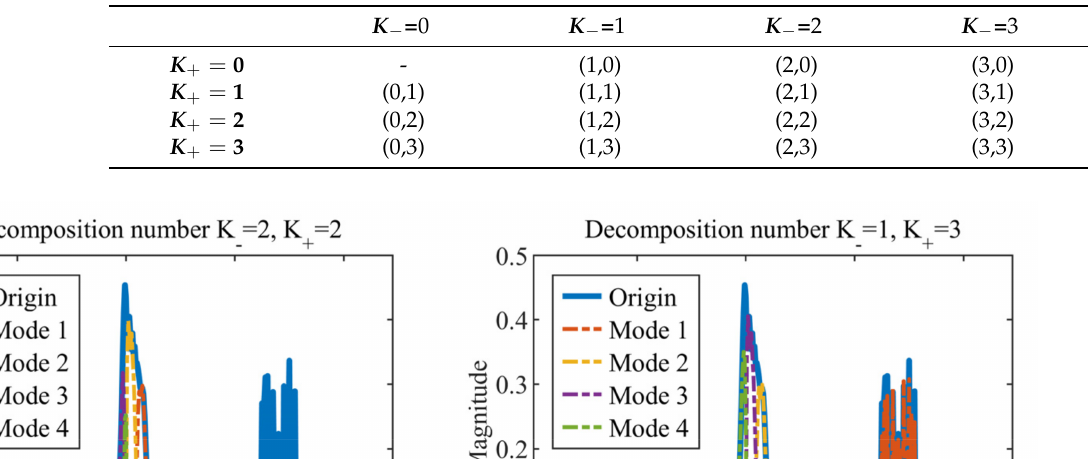
Table 3. Decomposition schemes for CVMD.